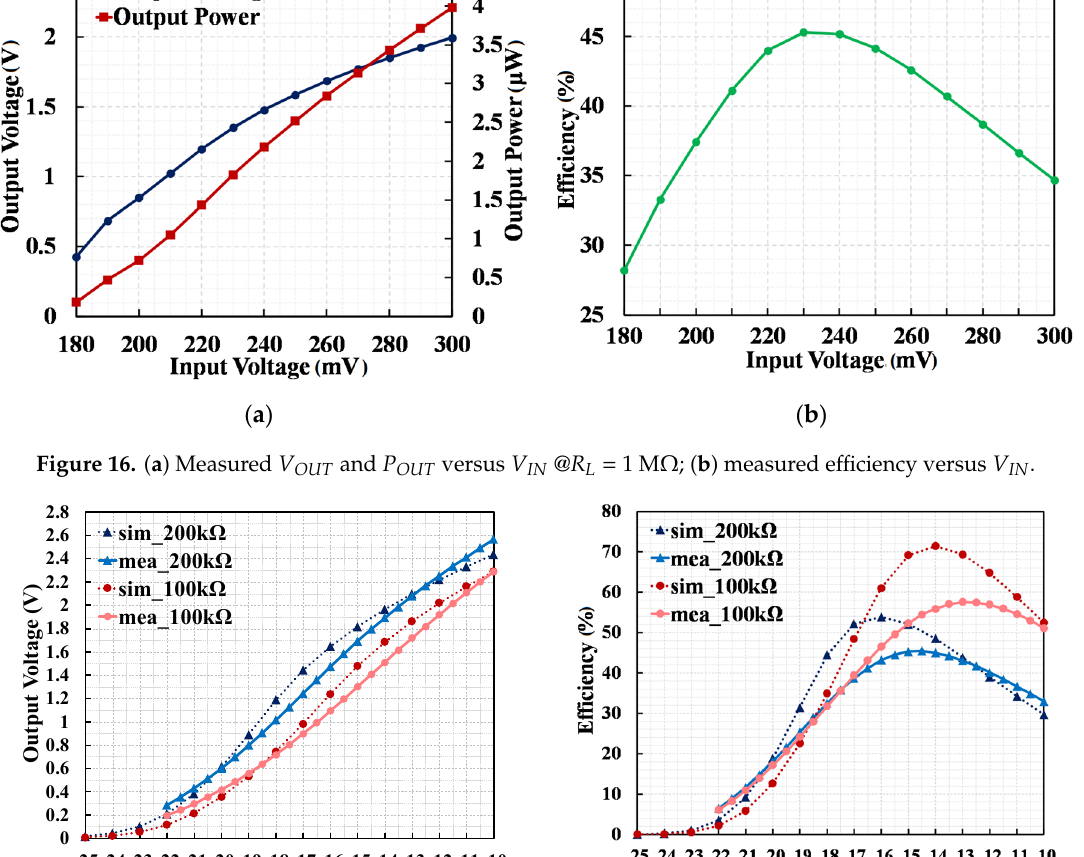
Figure 16. ( a ) Measured 𝑉 (cid:3016)(cid:3022)(cid:3021) and 𝑃 (cid:3016)(cid:3022)(cid:3021) versus 𝑉 (cid:3010)(cid:3015) @ 𝑅 (cid:3013) = 1 M Ω ; ( b ) measured efficiency versus 𝑉 (cid:3010)(cid:3015) .